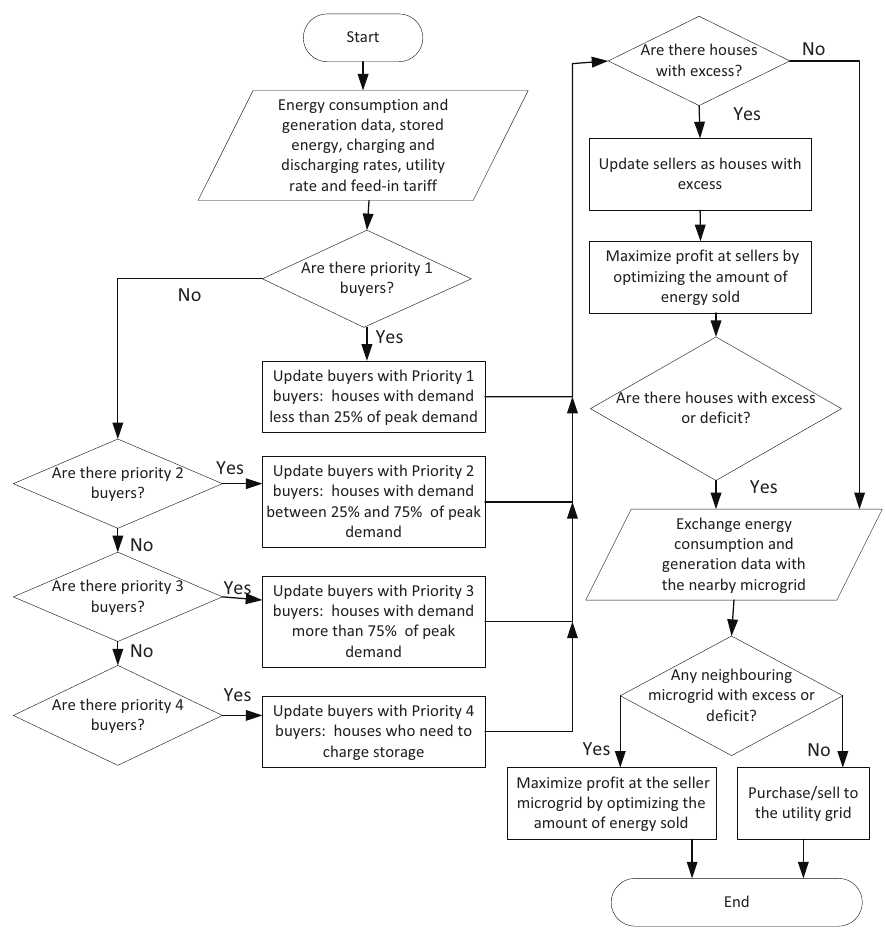
Figure 2. Flowchart illustrating intra-microgrid and inter-microgrid energy trading optimization stages for different priority